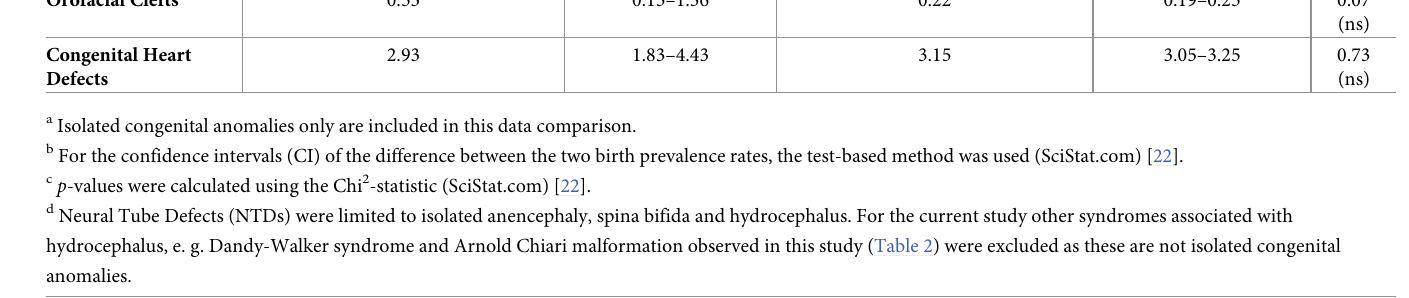
Confidence Interval b (95%)